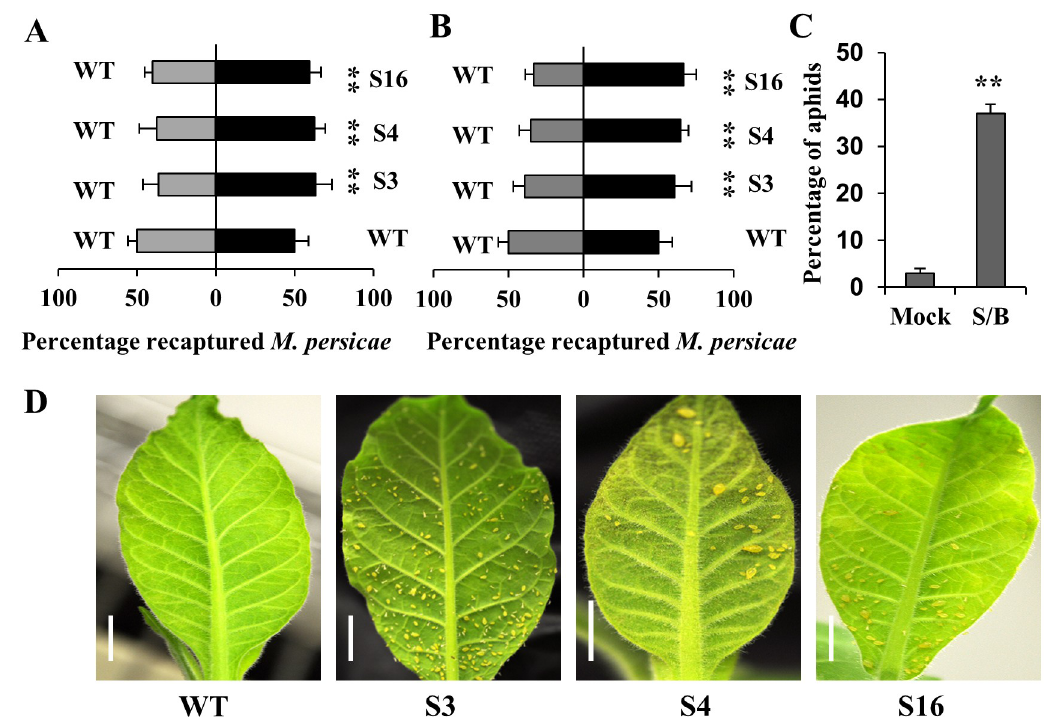
Fig 4. Green peach aphid choice experiments. (A) Transgenic tobacco lines emitting santalenes and bergamotene attracted aphids over the short-term in two-choice experiments (n = 8); (B) Long-term choice experiments for aphids using the transgenic lines and WT tobacco in a growth chamber (n = 8); (C) Green peach aphid two-choice experiments using agar medium plates treated with santalene and bergamotene solutions and hexane (n = 8); (D) Aphids on the leaves of transgenic line and WT tobacco in the long-term choice experiment, scale bar = 1 cm. WT, wild type; S, lines expressing SaSSy ; Mock, wild-type Nicotiana tabacum leaves treated with hexane; S/B, wild-type N . tabacum leaves treated with santalene and bergamotene solution. The mean ± SD values for eight biological replicates are shown. Asterisks indicate statistically significant differences from the WT based on Student’s t -test ( � P < 0.05 and �� P <